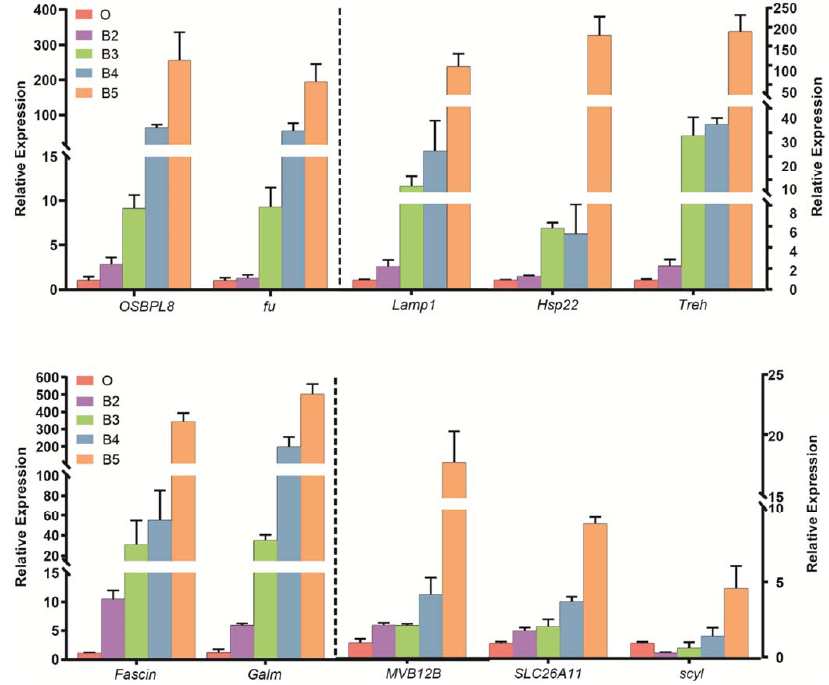
Figure 4. Expression of the selected 10 continually up-regulated DEGs by qRT-PCR. The data are shown as mean ± SE of three replications. O: the hatched first instar larvae, B2: the second instar larvae, B3: the third instar larvae, B4: the wandering larvae and B5: pupae. The left side of the dotted line shares the left Y axis, and the right side shares the right Y axis.